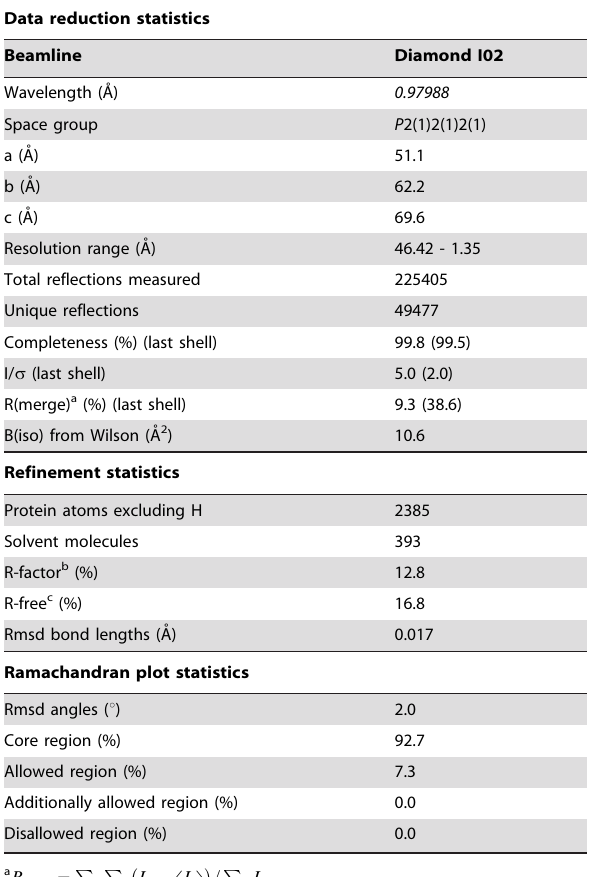
Table 1. Cystallographic